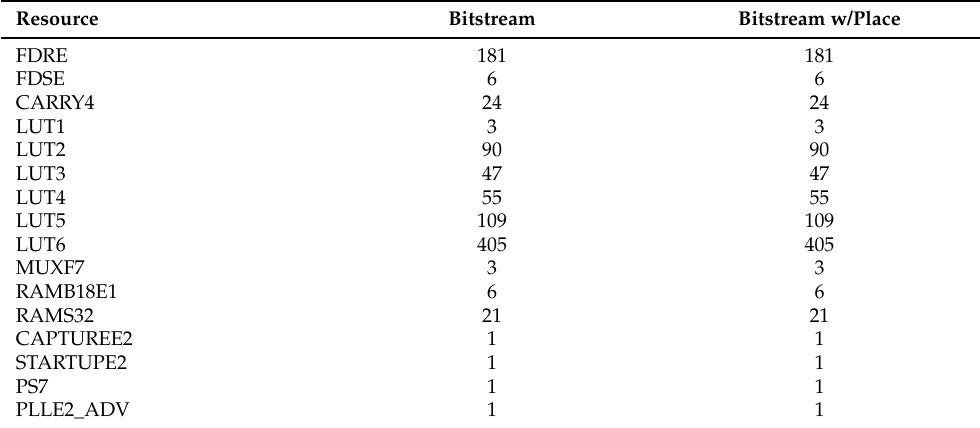
Table 3. Primitive utilization of a reconfigurable TMR implementation with and without placement constraints (@60